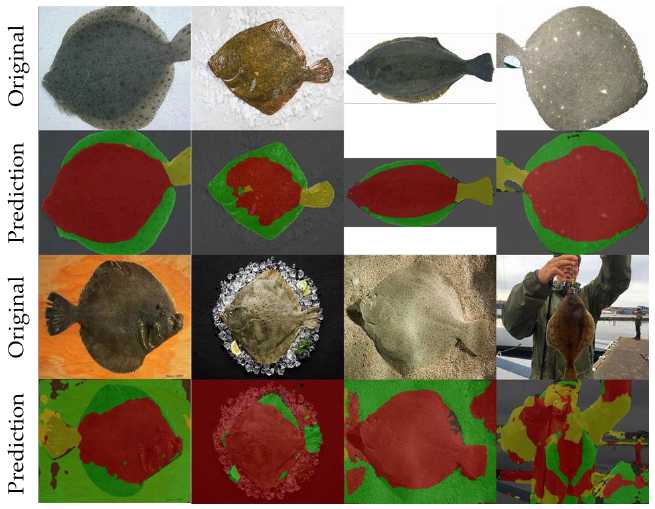
Figure 7. The segmentation results of internet images.